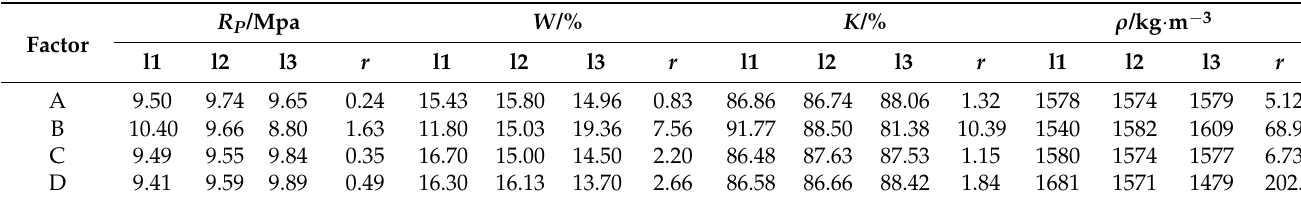
Table 3. Range analysis of the orthogonal test.